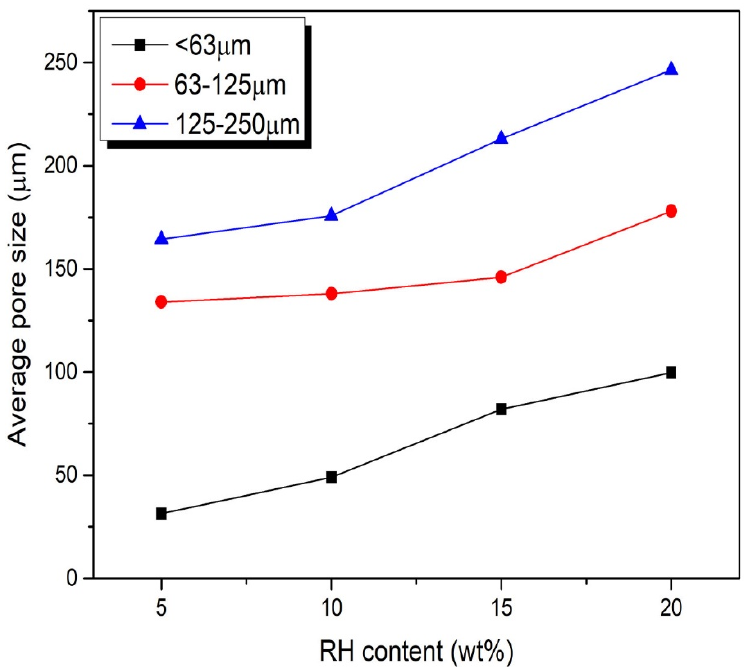
Figure 5. Variation in pore size of porous Al 2 O 3 ceramics with varying weight fractions of rice husk.